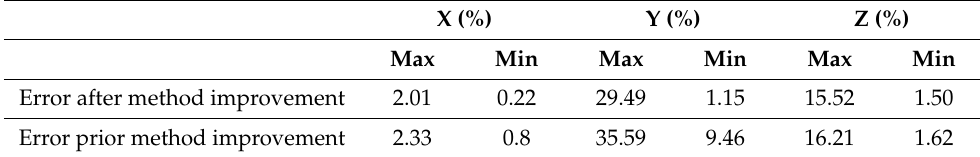
Table 7. Comparison of reconstruction error values before and after method improvement. X (%) Y (%) Z (%) Max Min Max Min Max Min Error after method improvement 2.01 Error prior method